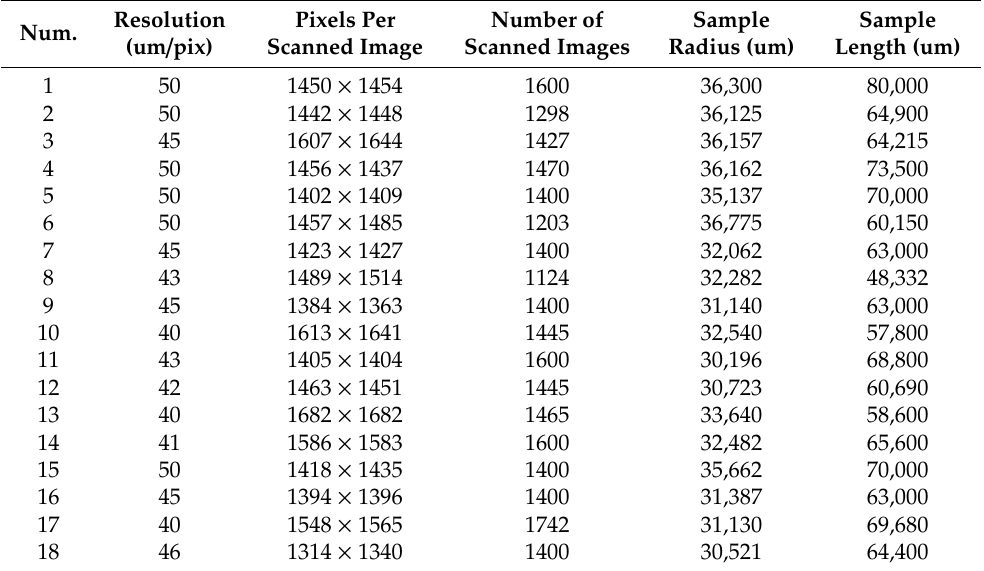
Table 1. The resolution, pixels per scanned image, and the amount of the scanned images, and the size information of all the samples.